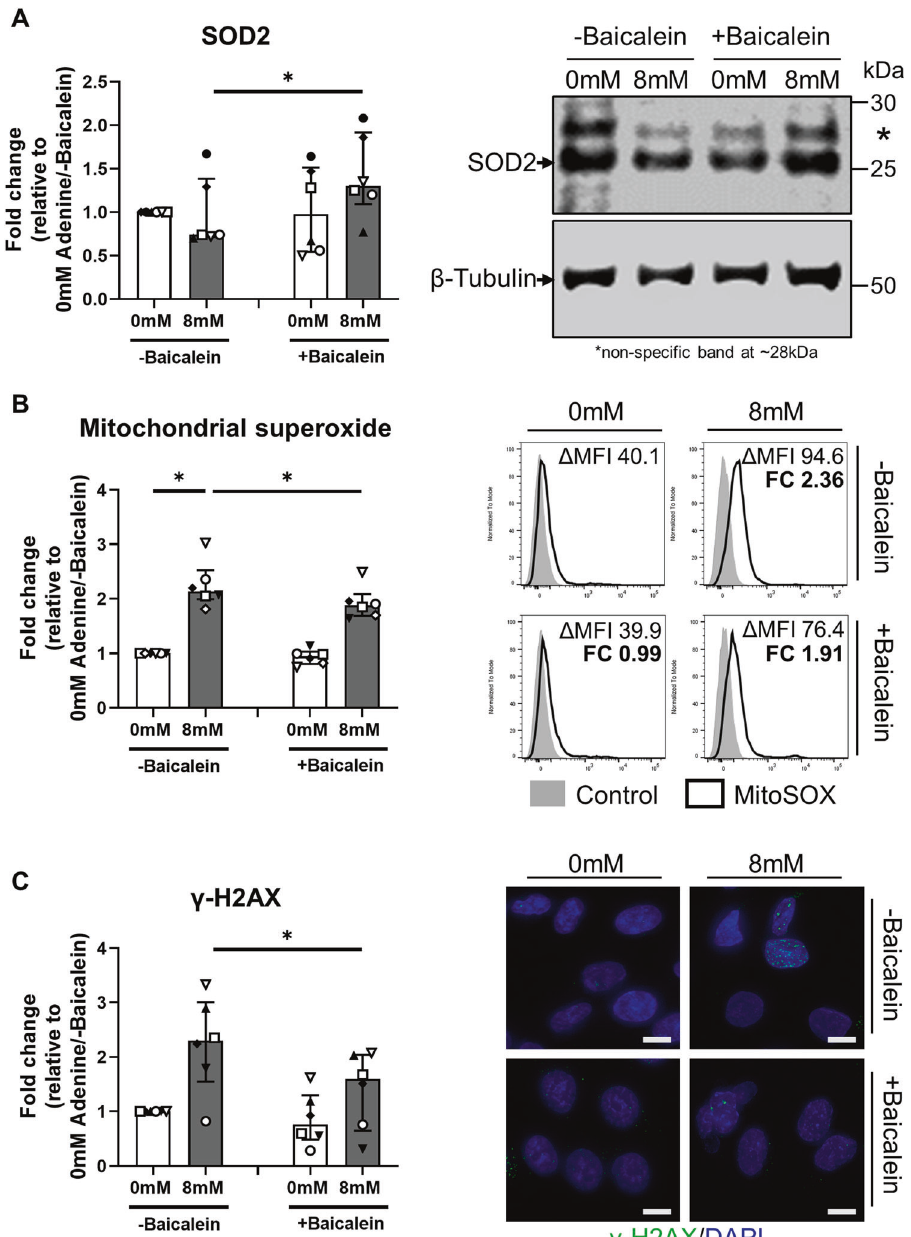
Fig. 5 Baicalein attenuates adenine-induced ferroptotic cell death in human primary PTEC via induction of SOD2. A Left panel: Fold changes (relative to 0 mM adenine without baicalein treatment) in SOD2 expression for PTEC cultured in the absence (0 mM) and presence (8 mM) of adenine, both without (-baicalein) and with ( + baicalein) treatment. Bar graphs represent median values with interquartile range. Symbols represent individual donor PTEC; n = 6. * p < 0.05, Wilcoxon matched-pairs signed-rank test. Right panel: Representative SOD2 Western blot for PTEC cultured in the absence (0 mM) and presence (8 mM) of adenine, both without (-baicalein) and with ( + baicalein) treatment (15 µg total protein per lane). B Left panel: Fold changes (relative to 0 mM adenine without baicalein treatment) in mitochondrial superoxide levels (measured as Δ MFI) for PTEC cultured in the absence (0 mM) and presence (8 mM) of adenine, both without (-baicalein) and with ( + baicalein) treatment. Bar graphs represent median values with interquartile range. Symbols represent individual donor PTEC; n = 6. * p < 0.05, Wilcoxon matched-pairs signed-rank test. Right panel: Representative MitoSOX staining (black un fi lled) compared with unstained control (grey fi lled) for PTEC cultured in the absence (0 mM) and presence (8 mM) of adenine, both without (-baicalein) and with ( + baicalein) treatment. Mitochondrial superoxide levels ( Δ MFI) are presented for each histogram, with fold change (FC) value relative to 0 mM adenine without baicalein treatment also shown. C Left panel: Fold changes (relative to 0 mM adenine without baicalein treatment) in γ -H2AX expression (measured as % cells with >5 γ -H2AX foci) for PTEC cultured in the absence (0 mM) and presence (8 mM) of adenine, both without (-baicalein) and with ( + baicalein) treatment. Bar graphs represent median values with interquartile range. Symbols represent individual donor PTEC; n = 6. * p < 0.05, Wilcoxon matched-pairs signed-rank test. Right panel: Immuno fl uorescent microscopy of representative PTEC cultured in the absence (0 mM) and presence (8 mM) of adenine, both without (-baicalein) and with ( + baicalein) treatment, and stained for γ -H2AX (green) and DAPI (blue). Scale bars represent 20 μ m.